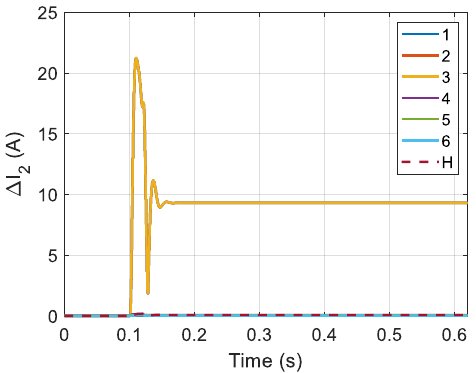
Figure 10. Negative sequence current magnitude.